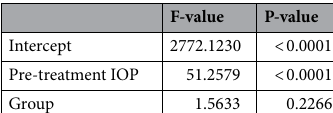
Table 3. The random intercept model for the pre-treatment intraocular pressure